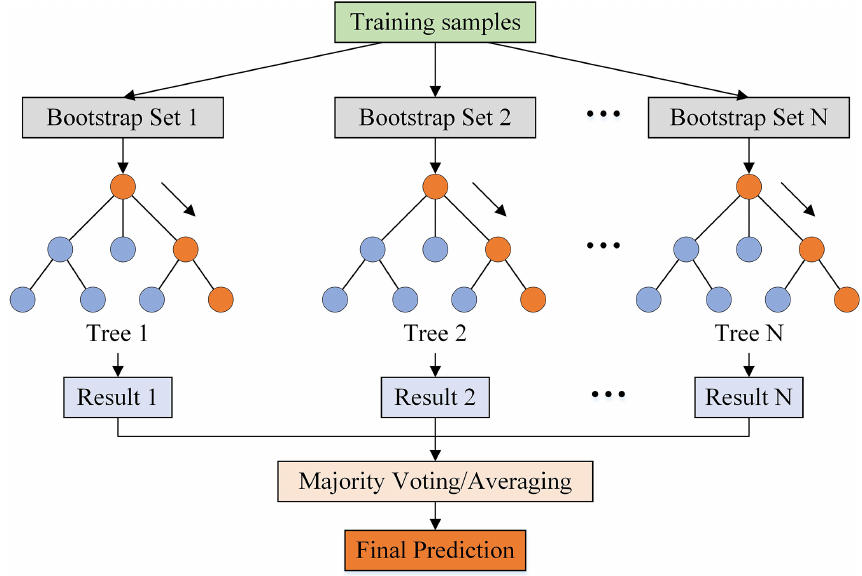
Figure 3. Overview of RF